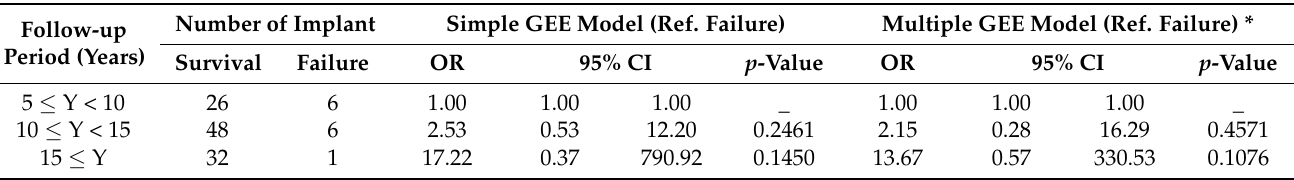
Table 6. Comparison of implant survival based on follow-up period (years).